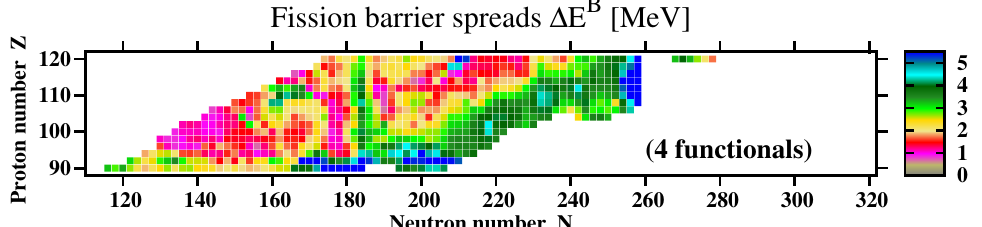
( Z , N ) and E B ( Z , N ) are max min